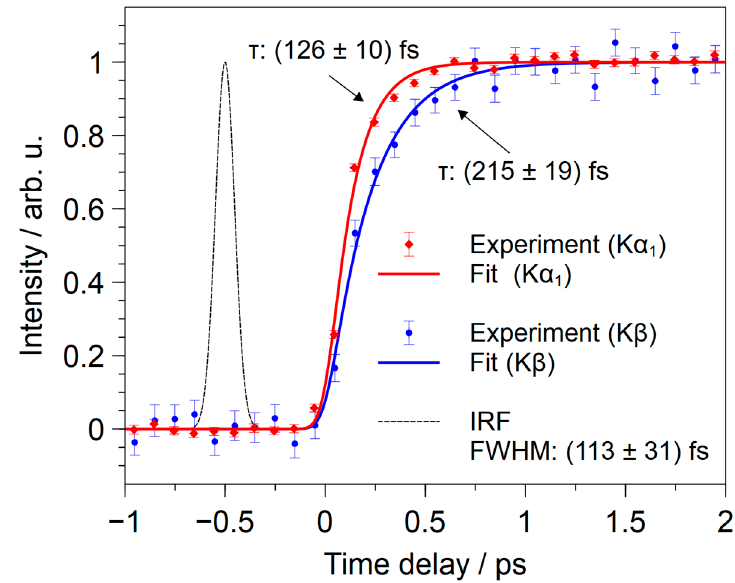
Figure 4. The kinetic traces as extracted from the di ff erence Fe K α and K β spectra calculated as integral of the absolute di ff erences in the energy regions indicated by the dashed lines in Figure 3B,C respectively. The dashed black curve represents the Gaussian instrument response functions as extracted from the fit to the K α data points (which is then propagated over the entire time delay in the convolution integral). The error bars on the plots correspond to one standard error directly propagated via sum of square errors of the di ff erence traces in Figure 3B,C.